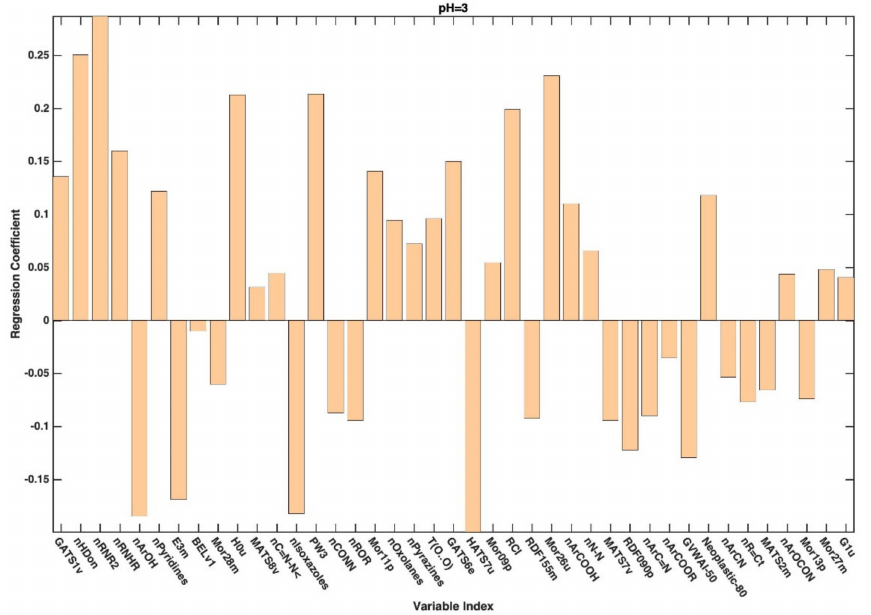
Figure A1. Regression coefficients associated to the descriptors selected by CovSel for the PLS-DA model based on the reduced dataset collected at pH 3.